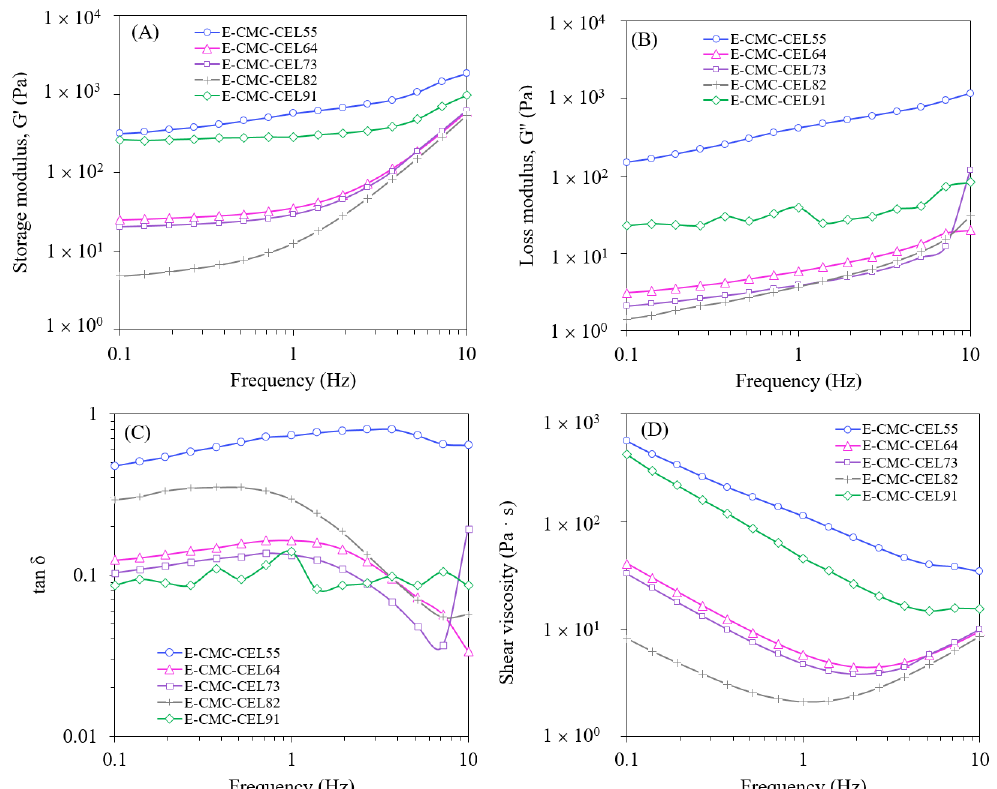
Figure 6. Rheological properties of cellulose hydrogel. ( A ) Storage modulus, ( B ) loss modulus, ( C ) tan δ and ( D ) shear viscosity of swelling gels.